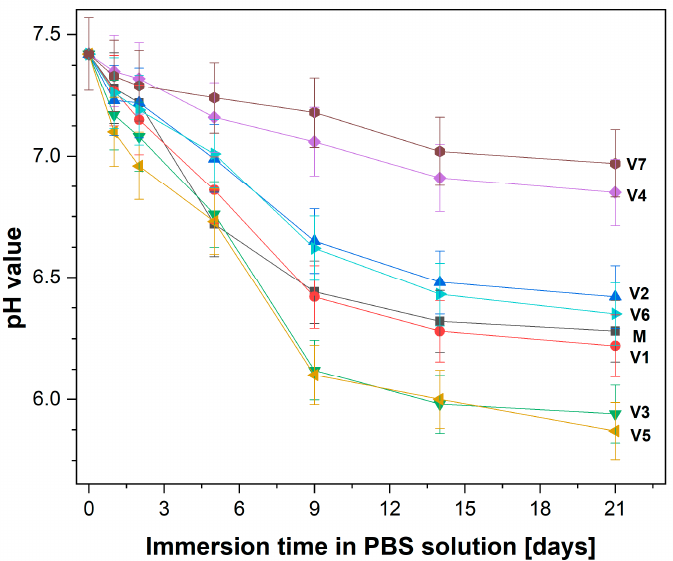
Figure 2. pH evolution of phosphate-buffered saline (PBS) solution as a result of glass sample immersion over 21 days at 37 °C.